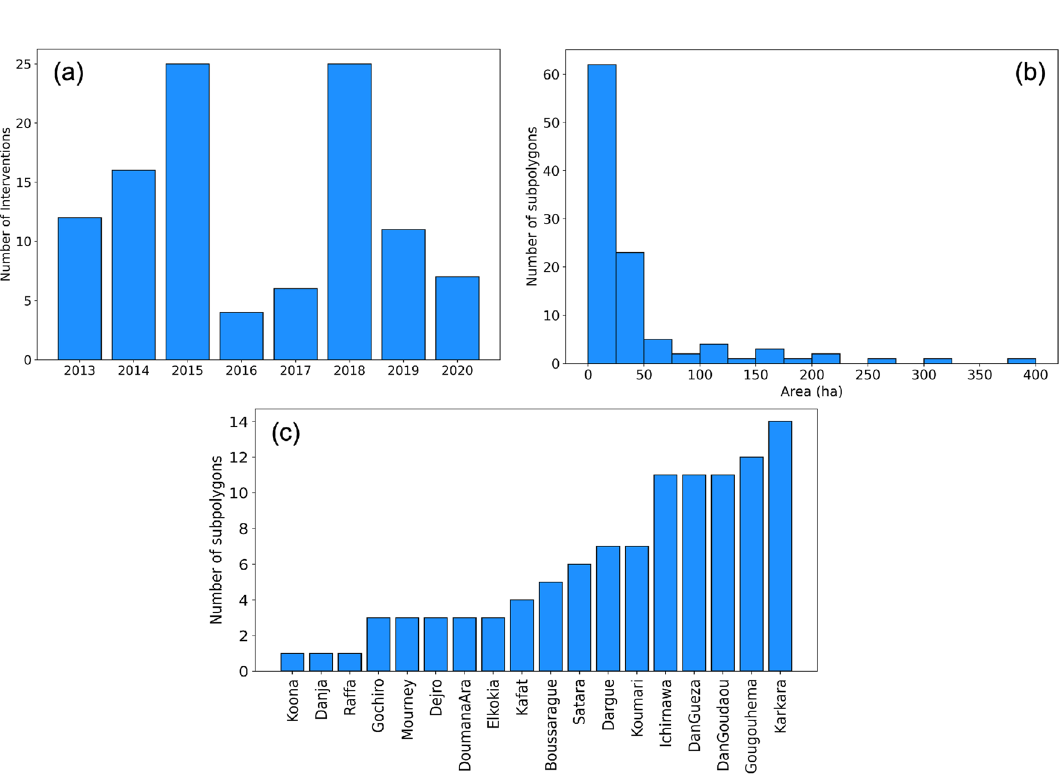
Figure 8. ( a ) shows the number of polygons intervened every year between 2013 and 2020. ( b ) is the histogram of the area in hectares for each of the polygons showing the distribution of polygon sizes. ( c ) elatively few were intervene represents the number of polygons at each of the sites that were intervened during the study period in the